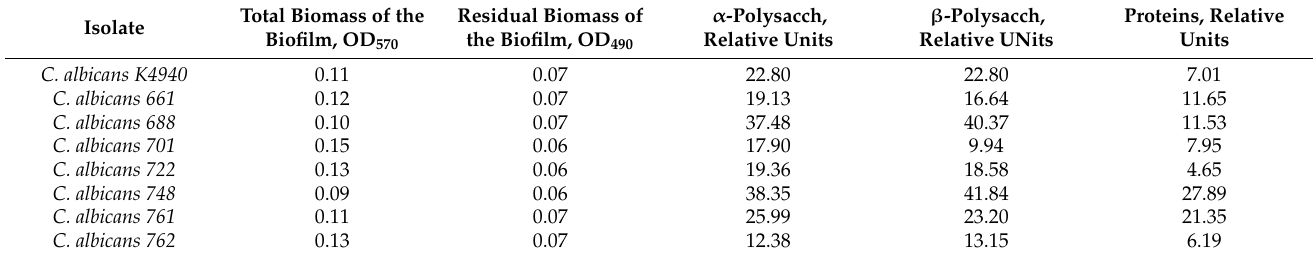
Table 2. Comparative assessment of the total biomass of biofilms and the relative content of polysac- charides and proteins in the matrix of biofilms of C. albicans isolates before and after treatment with Longidaza ®